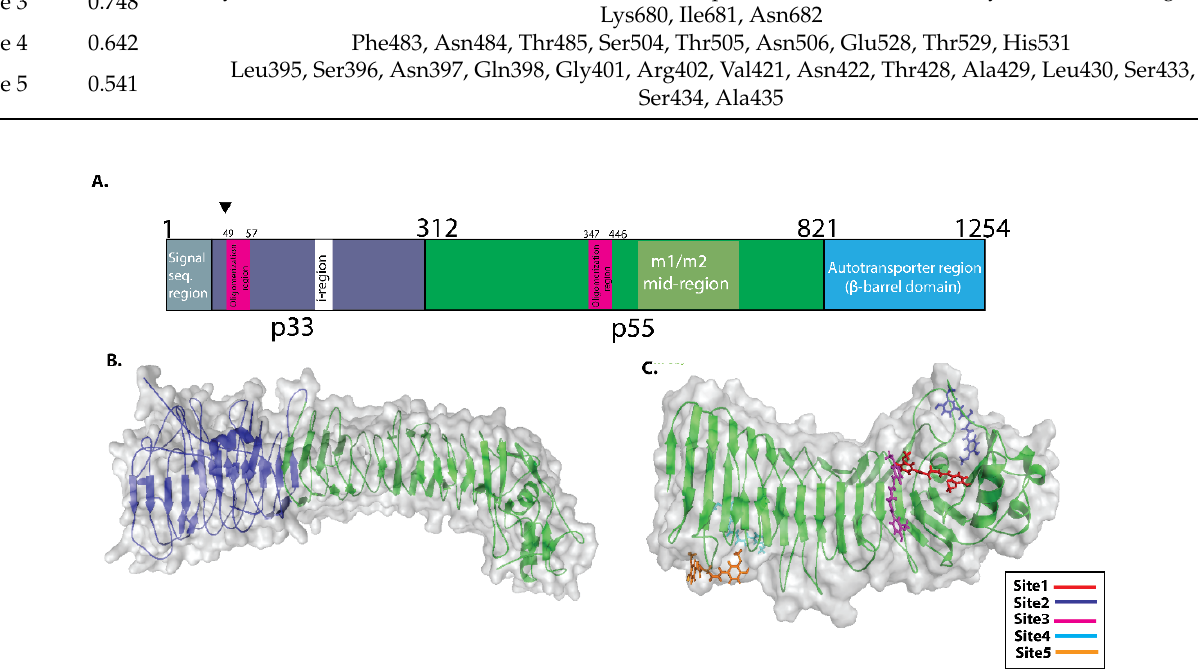
Figure 2. Schematic depiction of VacA protein structure and potential binding sites for Curcumin. ( A ) p33 domain of VacA protein (1–311 amino acid sequence region) (shown in blue colour). The p55 domain of VacA (312–821 amino acid sequence region) (shown in green colour). VacA p33 region includes an initial signal sequence, an oligomerization region in the middle, and an intermediate (“i”) region at the end. The mid-region amino acid sequences of the p55 domain of VacA protein define m1 and m2 isoforms ( B ) The VacA p33 and p55 are three-dimensional structures. (The p33 and p55 domains are shown in blue and green colors, respectively. ( C ) COACH server predicted potential binding site present in p55 domain of VacA protein. Site1, site 2, site 3, site 4, and site 5 are shown in different